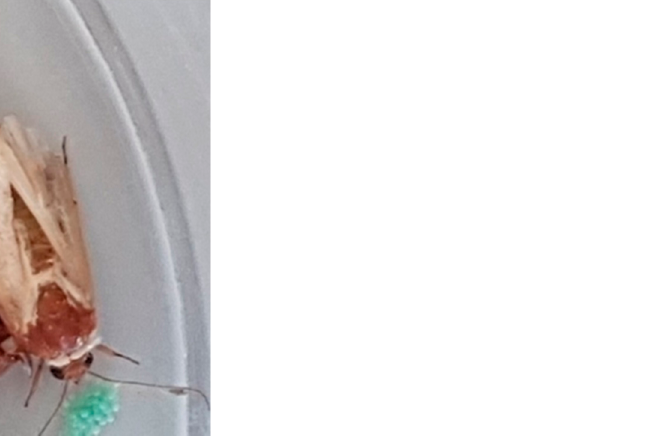
Figure 6. Representative virgin female moth having laid fertile eggs showing apparent parthenogenesis.